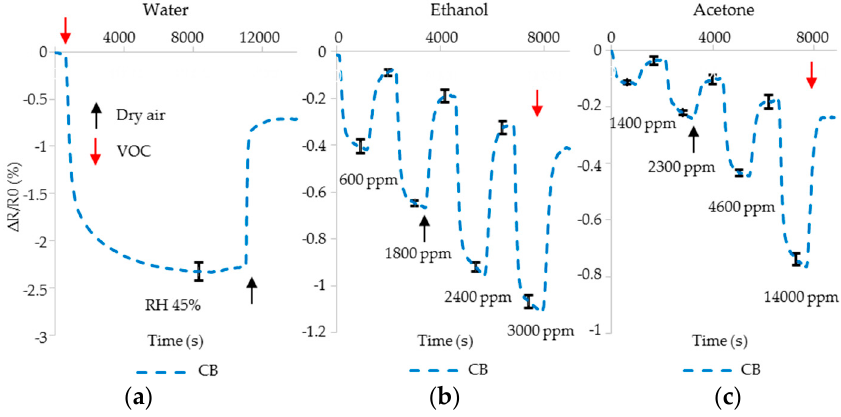
Figure 9. Resistance change of the CB sensors as they are exposed to ( a ) water vapor with RH 45%; various concentration of ( b ) ethanol and ( c ) acetone.